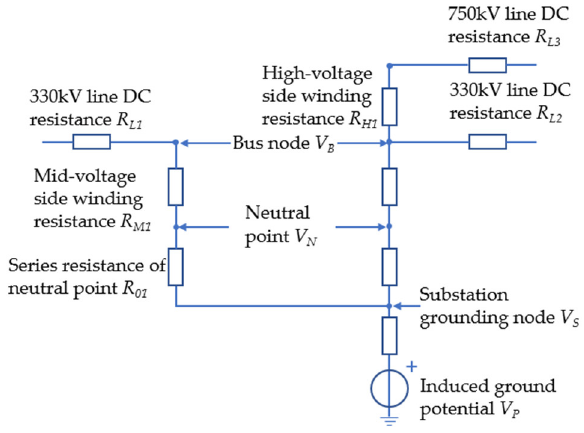
Figure 4. DC network equivalent model of a 750 kV substation.